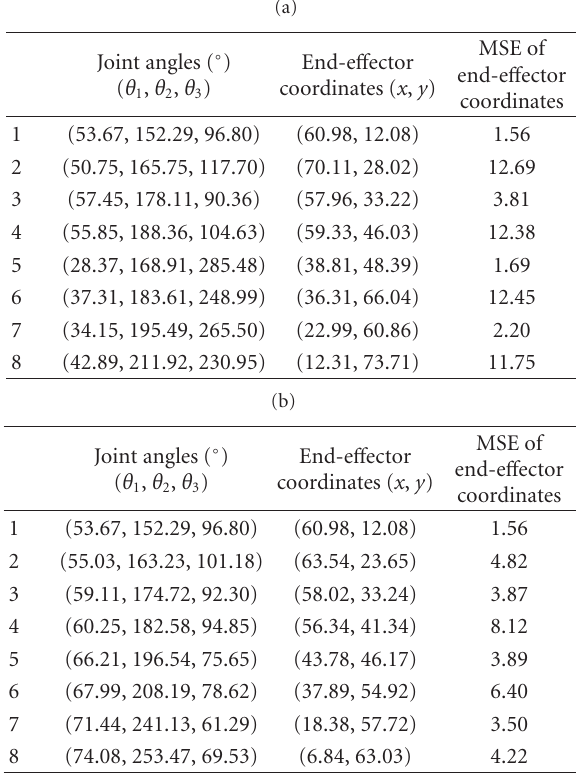
Table 5: Estimated joint angles, calculated end-e ff ector coordi- nates, and errors(a) with regularization F 3 ( x ) and (b) without regularization for ill-posed problem of